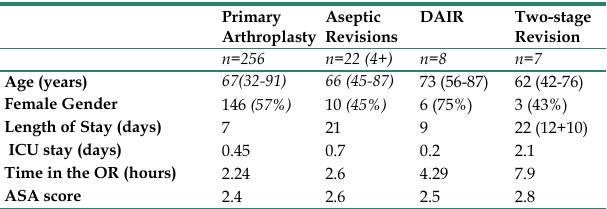
Table 2. Basic demographic and clinical data for 293 THA